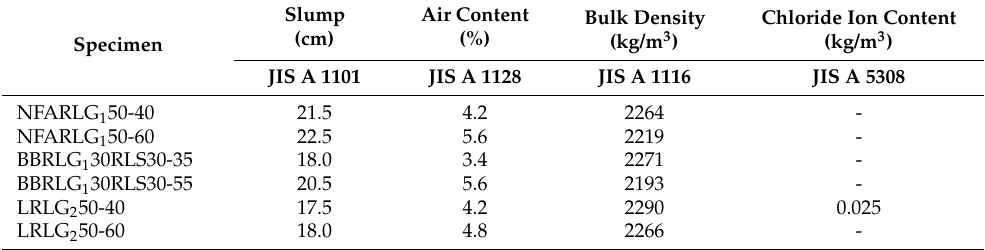
Table 8. Qualities of fresh concrete.